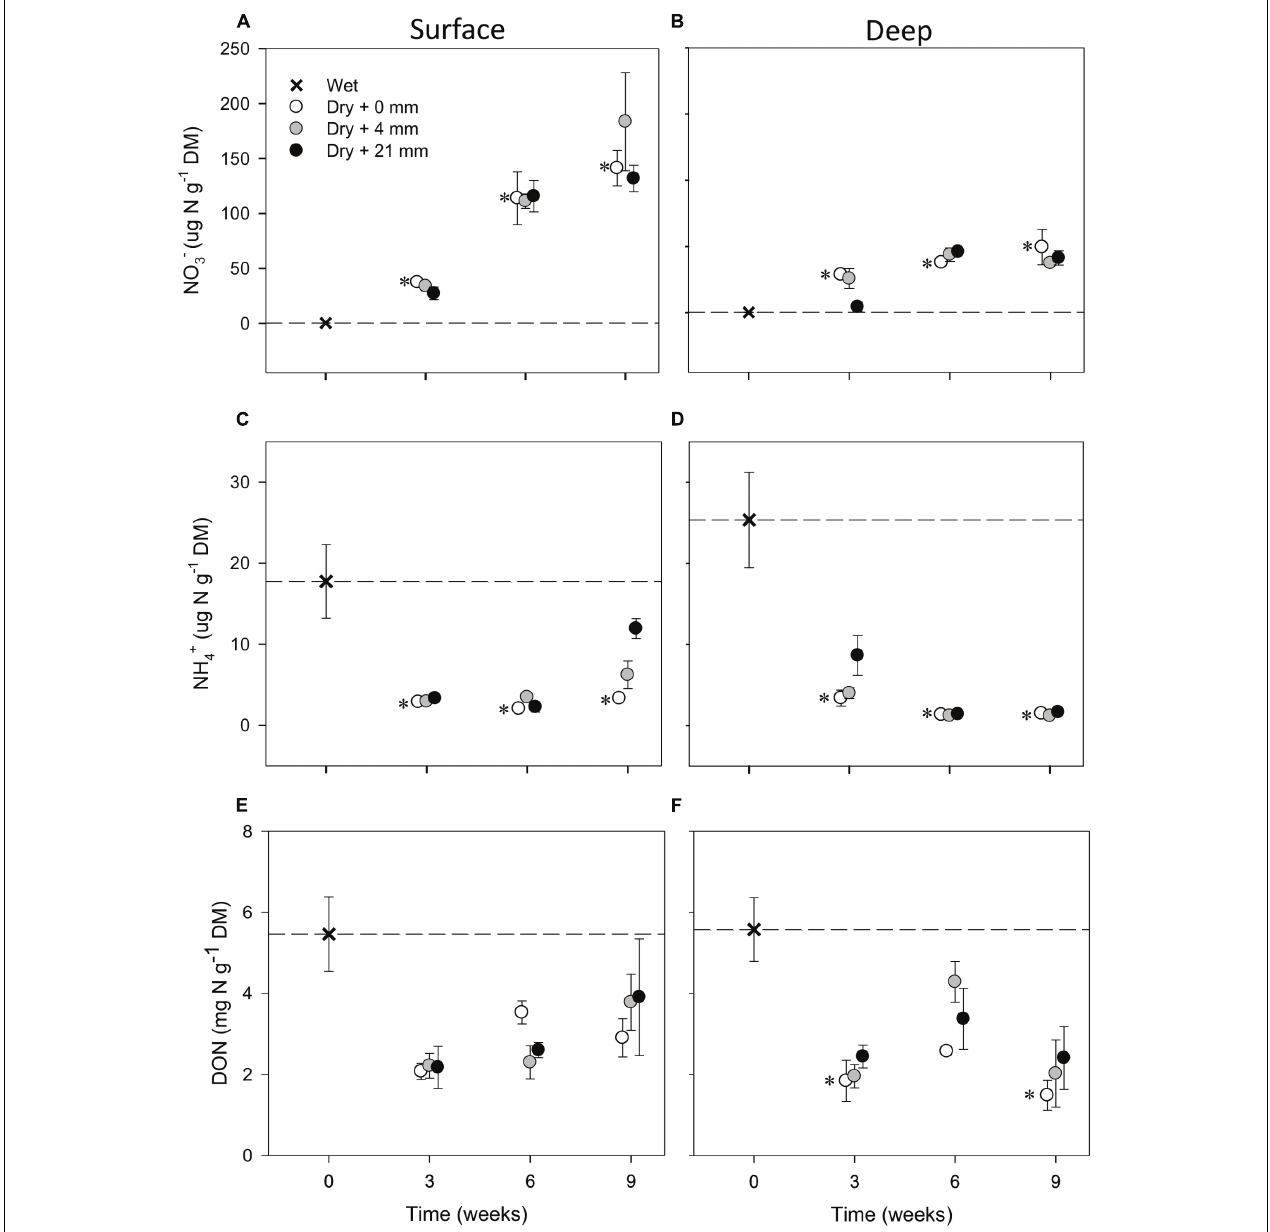
FIGURE 2 | Mean ( ± SE, n = 3) concentration of NO 3 − , NH 4 + , and DON in surface (A , C , E , respectively ) and deep sediments (B , D , F , respectively ) during initial conditions (i.e., 0 weeks) and after the different RMs for each DPD. Asterisks ( ∗ ) denote significant ( P ≤ 0.05) differences to initial wet conditions after Student’s t -test followed by Holm’s correction for multiple comparisons. The dashed line represents the initial conditions as a reference for a better